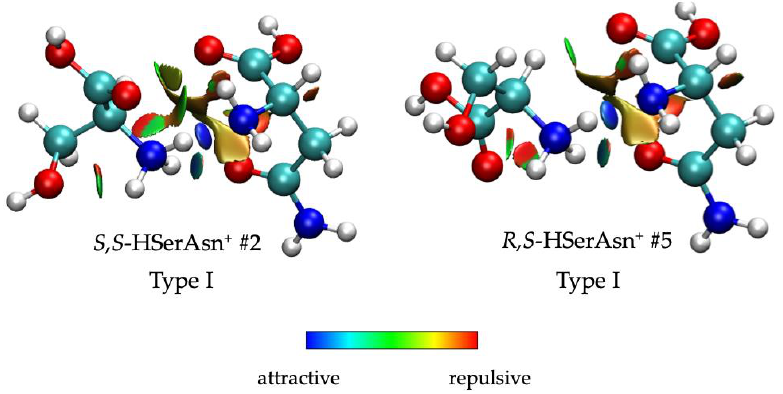
Figure 8. NCI plots of the most stable homo- and heterochiral HSerAsn + at an iso-surface value of